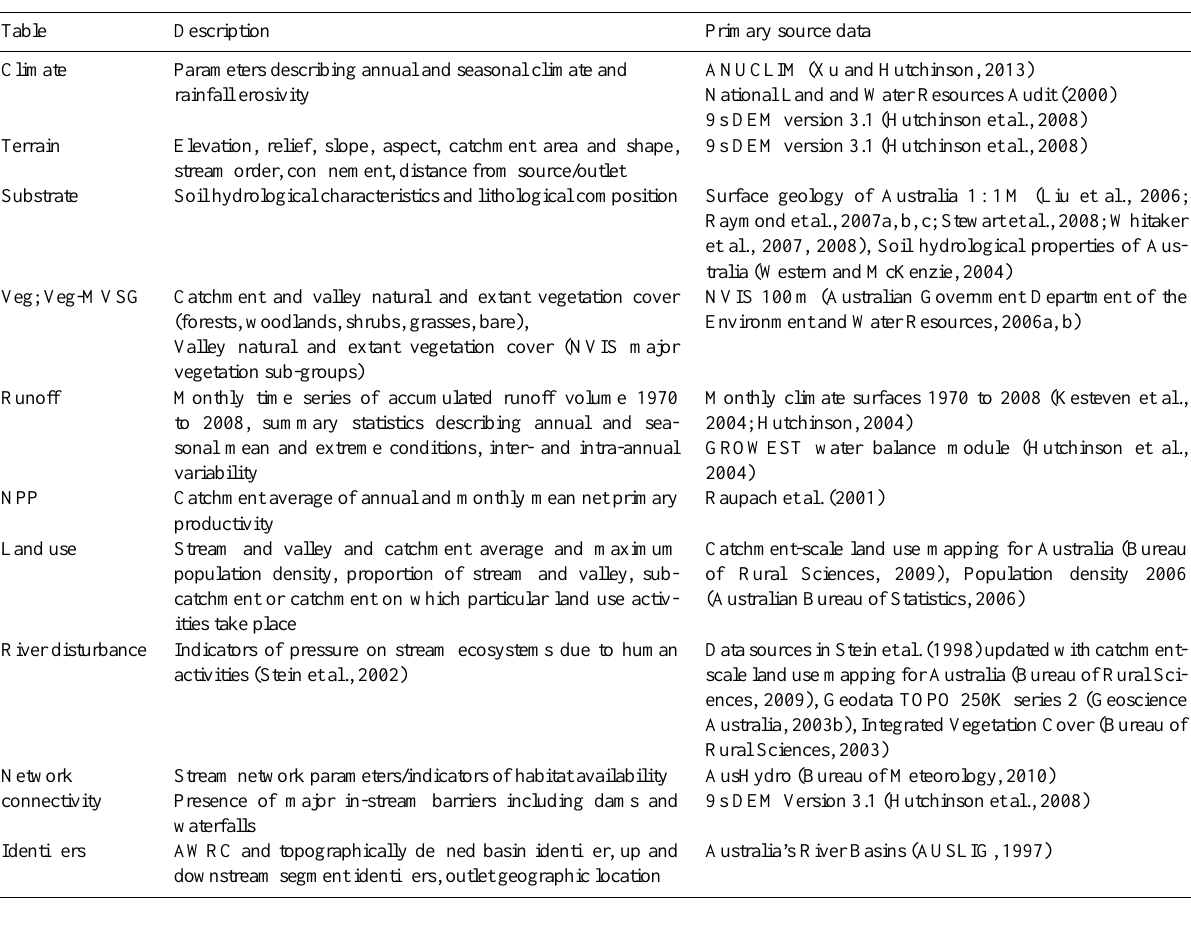
Table 3. Stream environment descriptors. Data are organised into lookup tables that can be related to both the DEM streams and catchment spatial layers using a shared segment